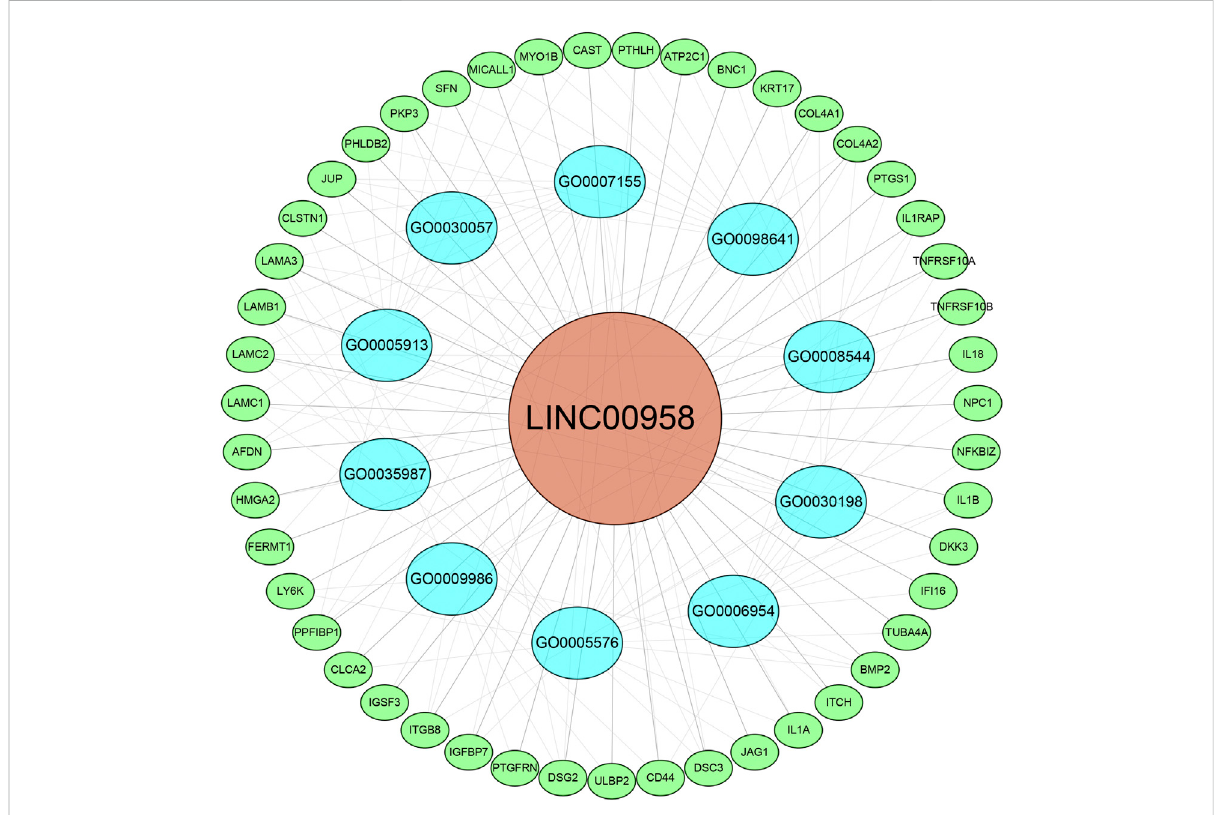
FIGURE 11 Differentially expressed gene interaction network analysis. Green nodes represent target genes, and blue nodes represent the related pathway. As indicated in red, LINC00958 is localized at the center of the